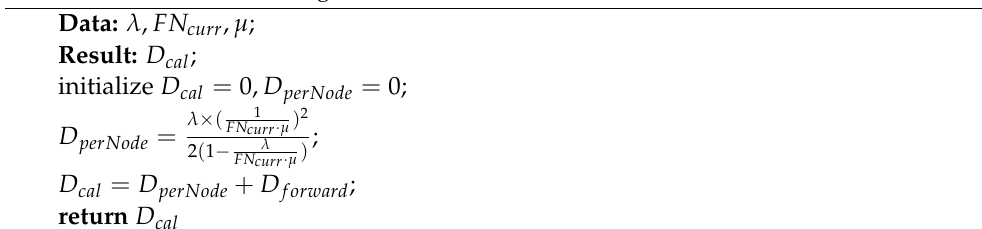
Algorithm 2: f ind _ D cal ( λ , FN curr , µ ) : calculate the expected delay in the system with current number of fog